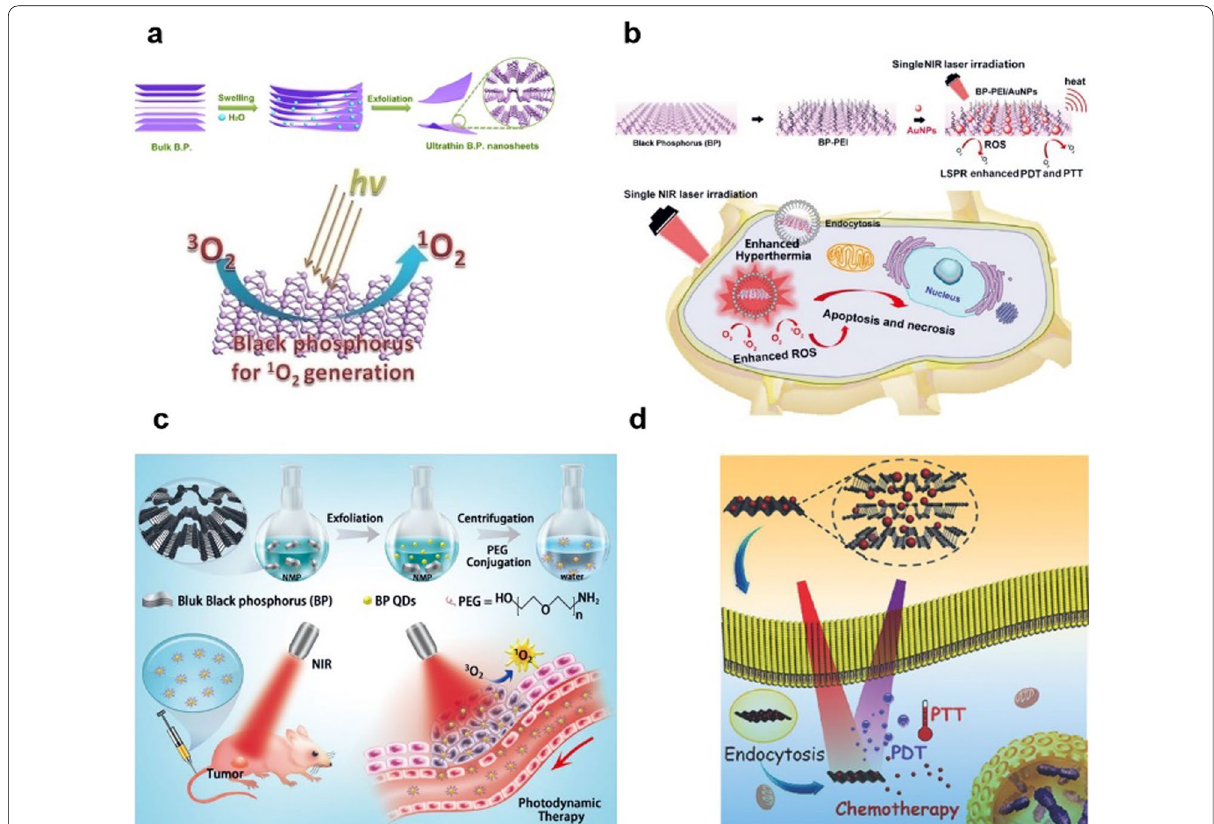
Fig. 3 a Schematic diagram for the water exfoliation of bulk B.P. into ultrathin nanosheets. b The preparation and schematic view of the biofunction of BP-PEI/AuNPs. In cancerous cells, the enhanced PTT/PDT by localized surface plasmon resonance (LSPR) could simultaneously enhance hyperthermia and singlet oxygen for cancer phototherapy. c Schematic diagram of the synthesis of BPQDs and their potential application in PDT. d Abridged general view of BP-based drug delivery system for synergistic photodynamic/photothermal/chemotherapy of cancer